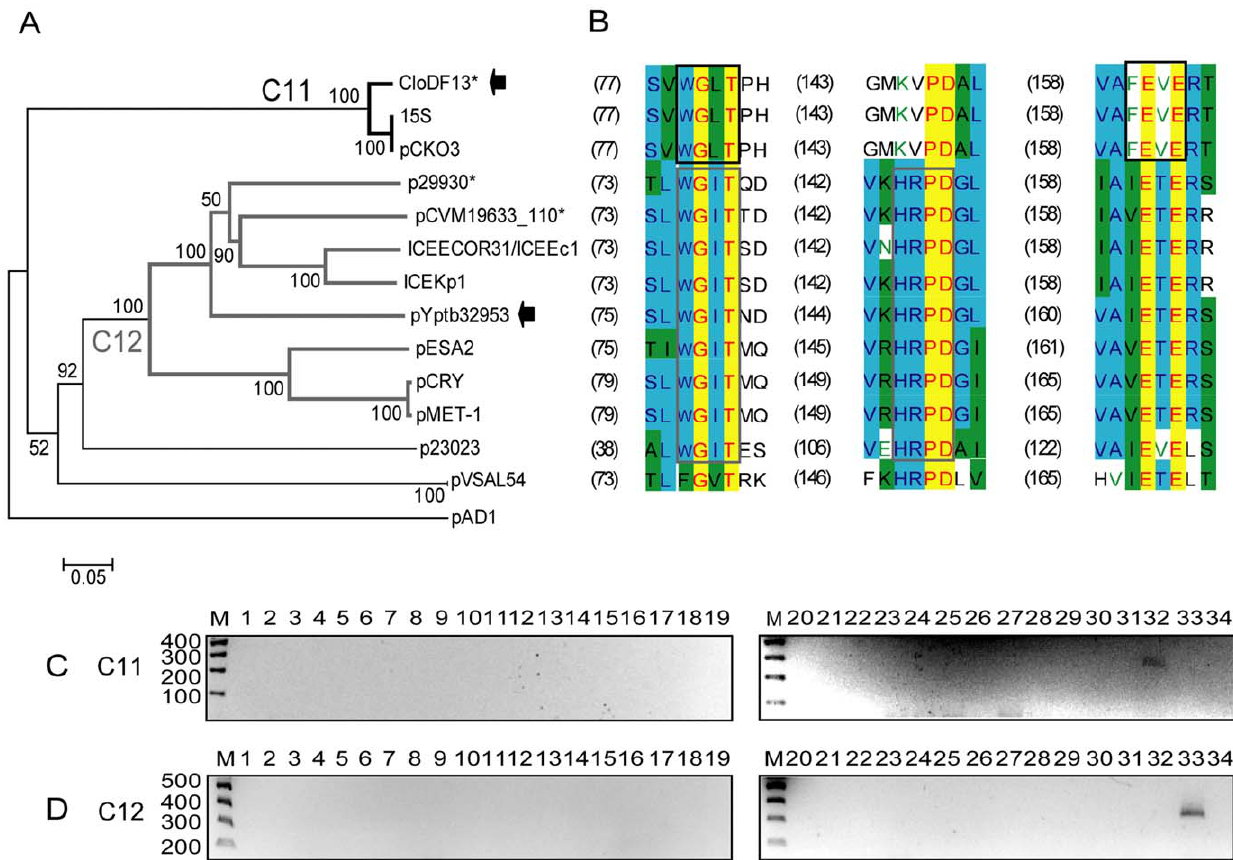
Figure 7. DPMT validation for MOB C relaxases. A) Phylogenetic tree of MOB C relaxase family. B) Alignment of the relaxase motifs used to design the MOB C degenerate primers (C11-f + C11-r, continuous black; C12-f + C12-r, continuous dark grey). C) Amplicons obtained with primers for subfamily MOB C11 (C11-f and C11-r). D) Amplicons obtained with primers for subfamily MOB C12 (C12-f and C12-r). Symbols, colour codes and lanes as in Figure 1.